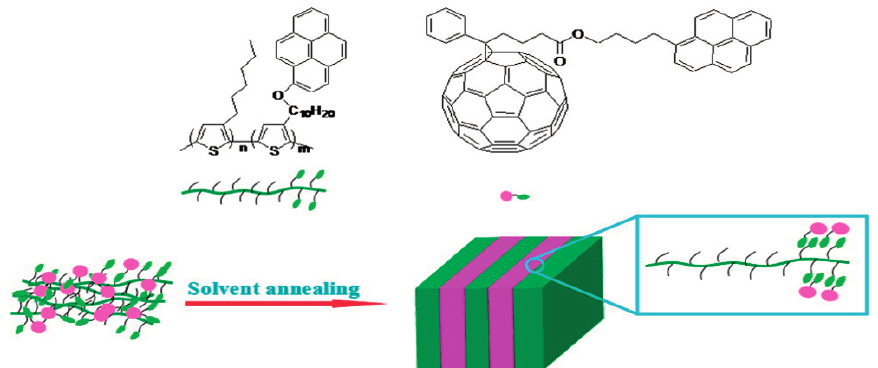
Figure 8. Chemical structures of copolymer donor P3HT- b -P3TPy and fullerene